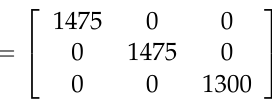
For electrical boundary conditions, a sinusoidal voltage was applied to the PZT patch. In the process of simulation, the voltage at the interface between the PZT patch and aluminum alloy plate was set to zero, and an alternative voltage was applied on the opposite surface of the PZT patch against the interface. The excitation voltage V p-p loading on the PZT patch (peak to peak) was 400 V. The simulation results are shown in Figure 7.